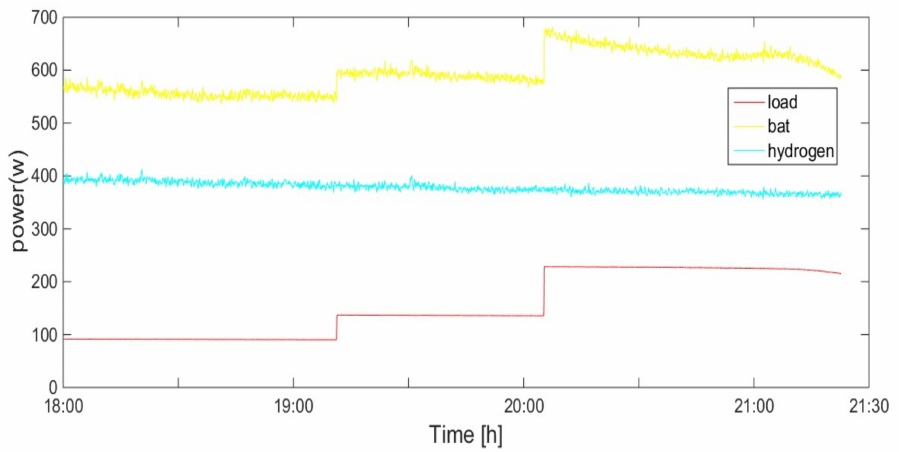
Figure 17. Power curves in scenario 5.